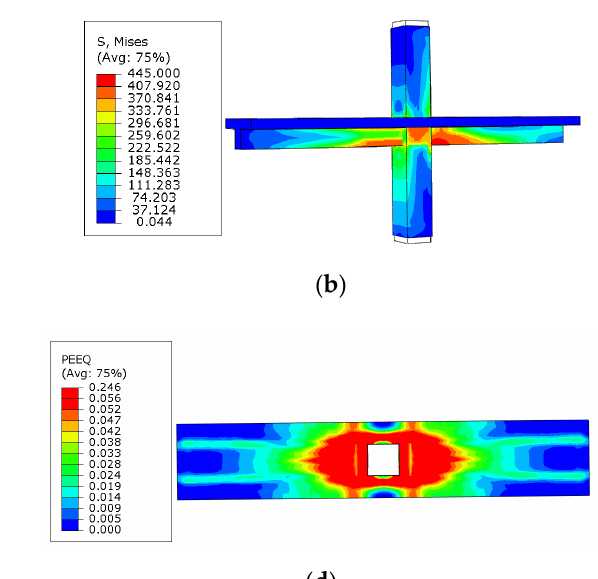
( e ) Figure 9. Boundary conditions scheme and finite element models: ( a ) boundary conditions scheme; ( b ) the whole model; ( c ) RP connection; ( d ) RS connection; ( e ) RT connection. 5. Numerical Results 5.1. Verification of FEA Model 5.1.1. Failure Mode In order to verify the feasibility and accuracy of the developed finite element model in section 4, the finite element analyses under cyclic load of the three tested specimens are conducted and the numerical results are compared to those from the experiments.